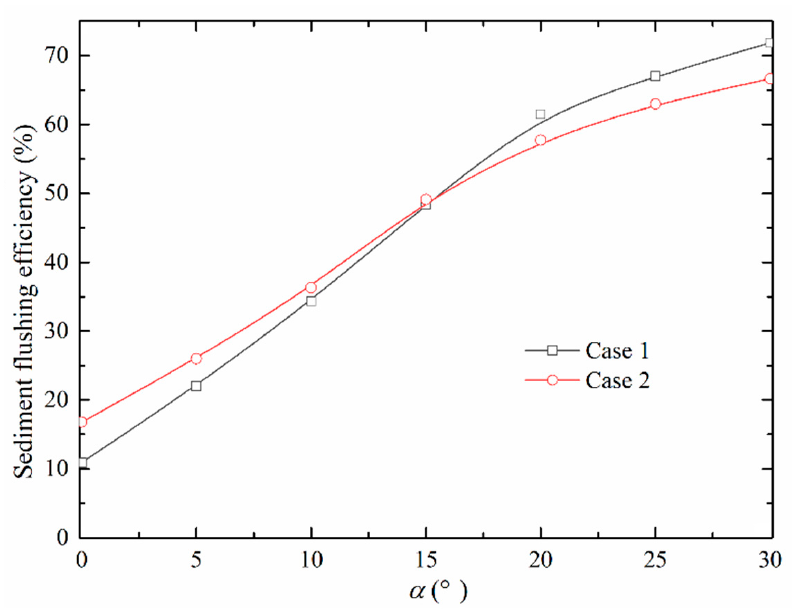
Figure 16. Sediment flushing efficiency as a function of guide-vane angle.